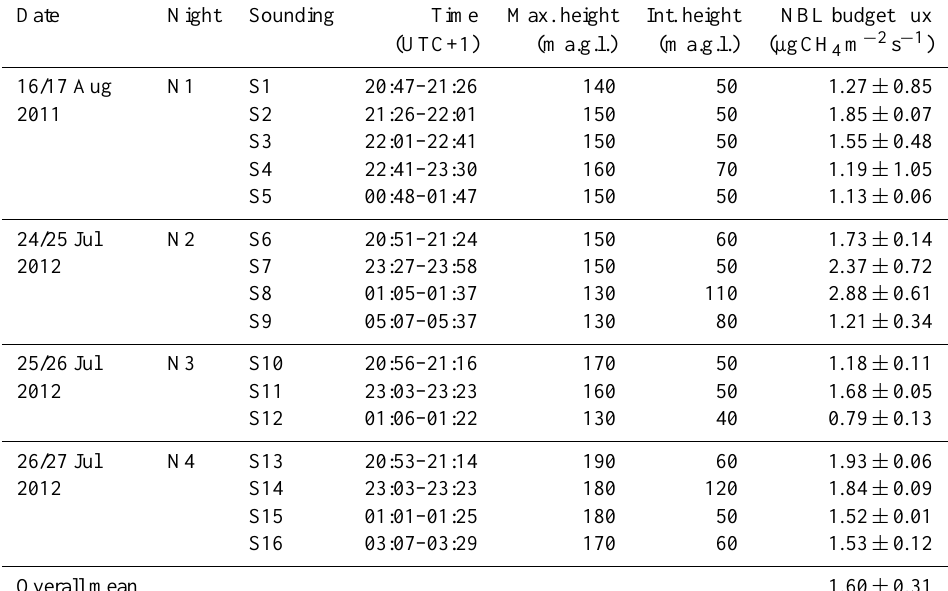
Table 1. Overview of the balloon measurements in 2011 and 2012 with the maximum height reached, the integration height in the time–height kriging interpolation, and the resulting averaged NBL budget fluxes (mean ± SD, where SD is the standard deviation of all 0.3h time slices in the time–height kriging interpolation included in the calculation of the respective mean flux). The difference between two consecutive interpolated time slices was used to approximate the local derivative of concentration over time as detailed in Sect. 2.5. Max.